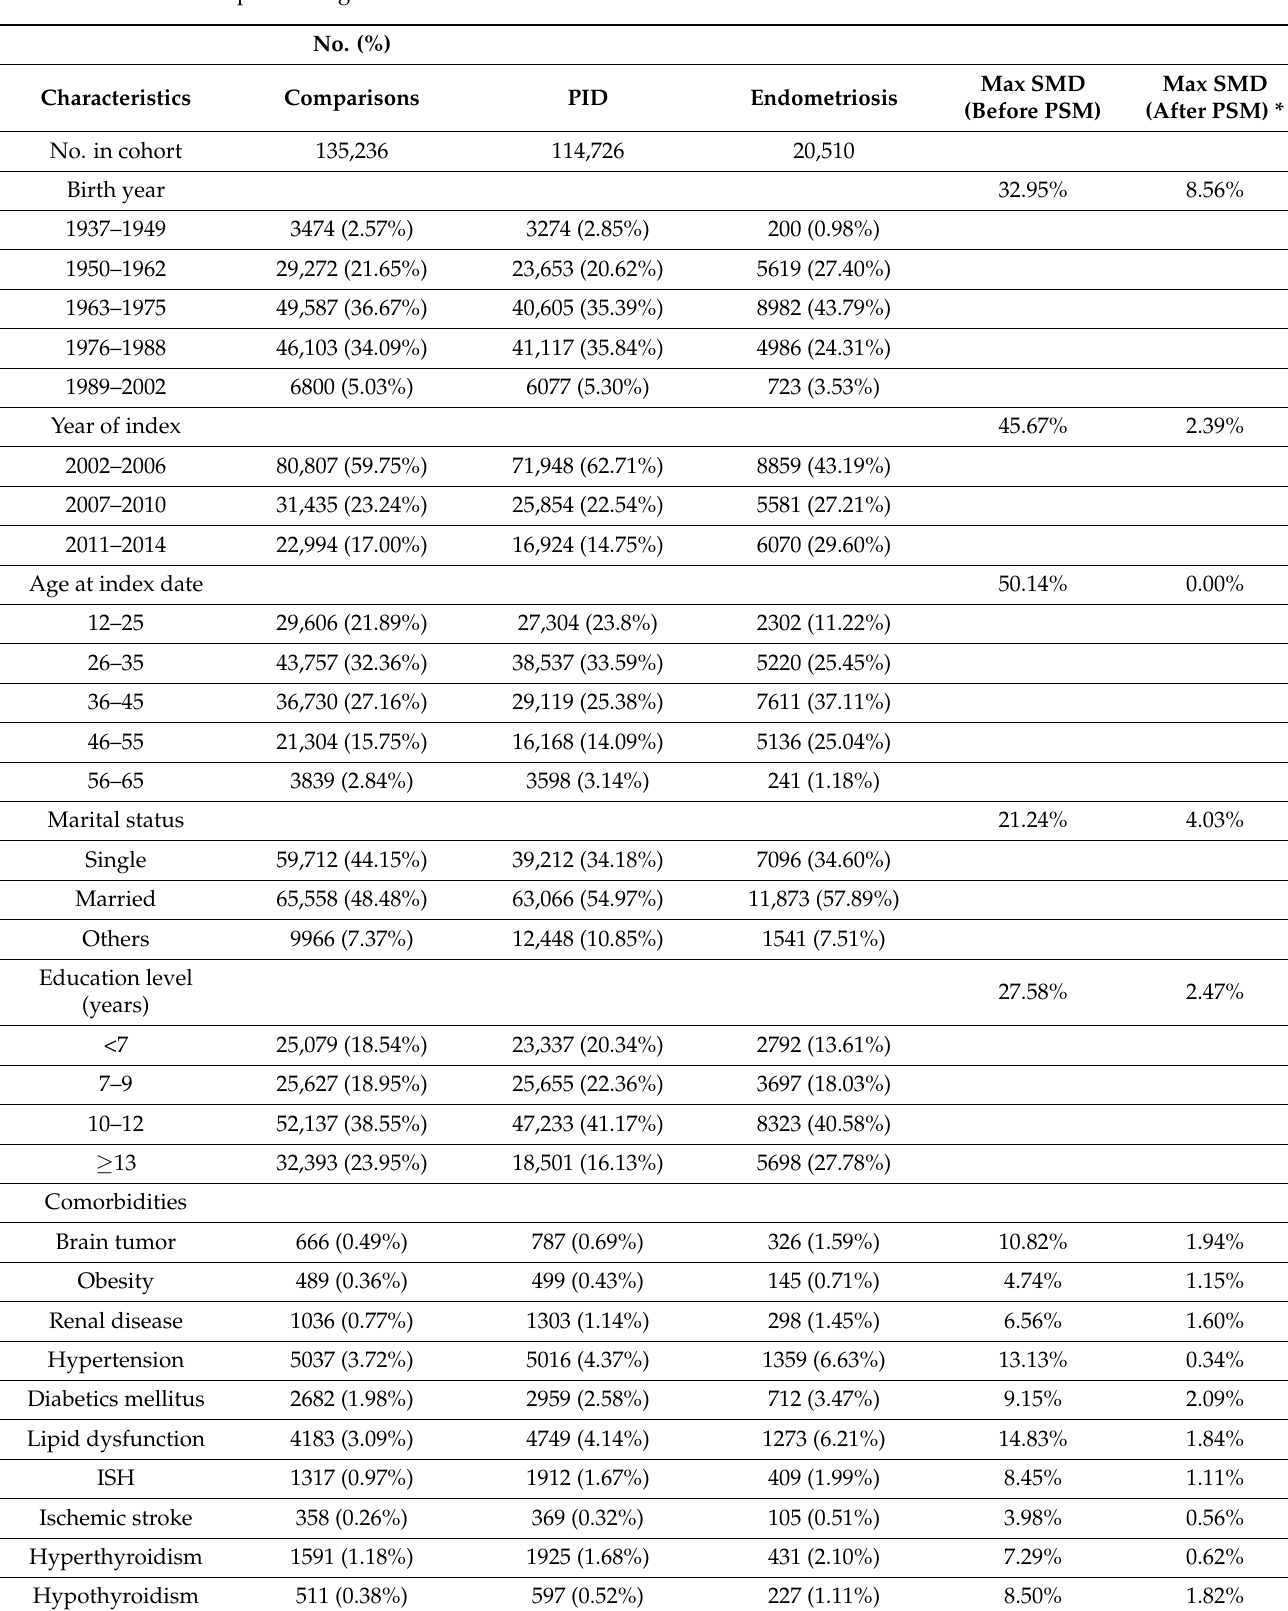
Table 1. Baseline characteristics of exposure (PID or endometriosis) and comparison cohorts with age and birth year matched and after performing